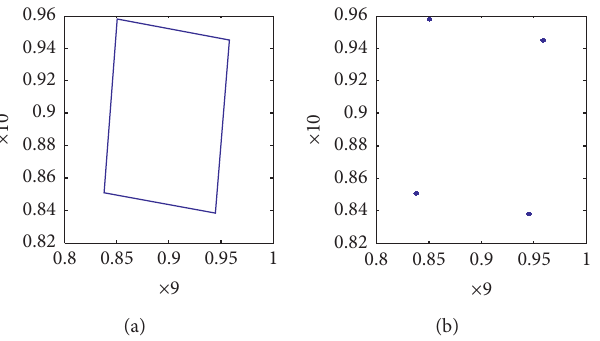
Figure 15: ω � 170 and k � 0 . 248without random perturbation. w (a) Phase trajectories. (b) Poincare maps.